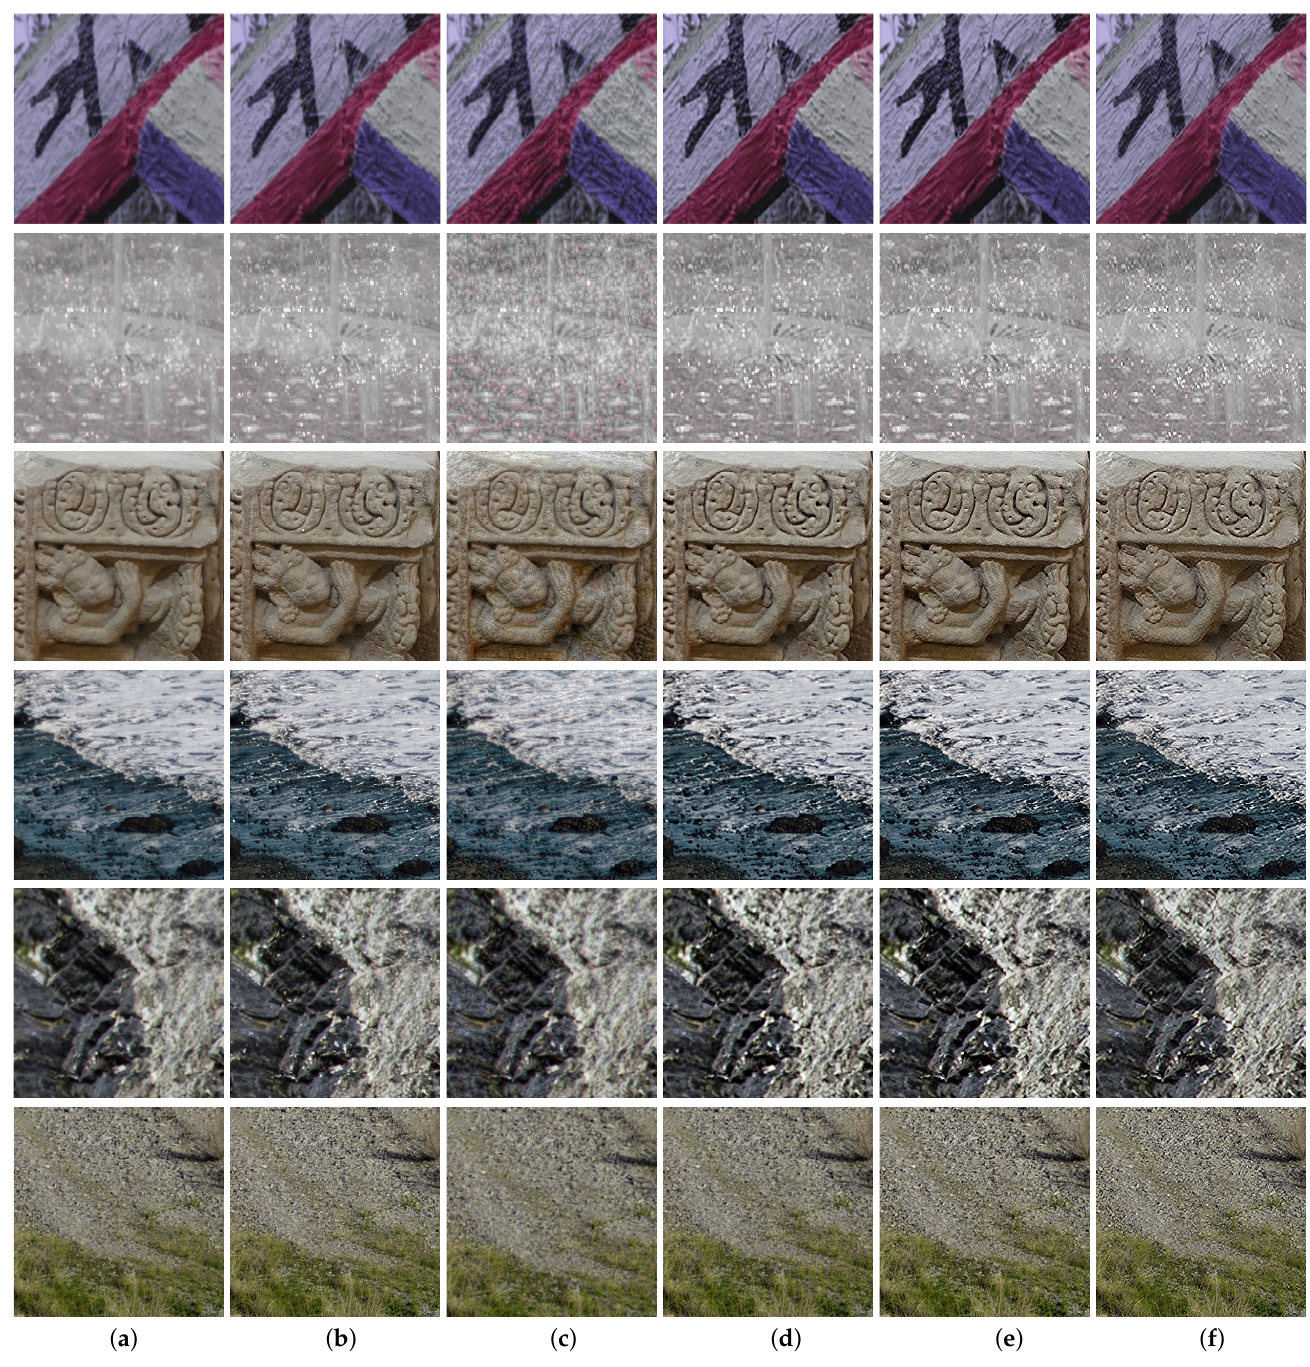
Figure 7. Enhancement results of images. ( a ) Original image. ( b ) By the Unsharp masking method. ( c ) By the CAIDE method. ( d ) By the MESM method. ( e ) By the CWM method. ( f ) By the proposed method. Figure 8 analyzes how each method enhances detail image signals. For a better under- standing, the horizontal signals of the enhanced images are presented in one